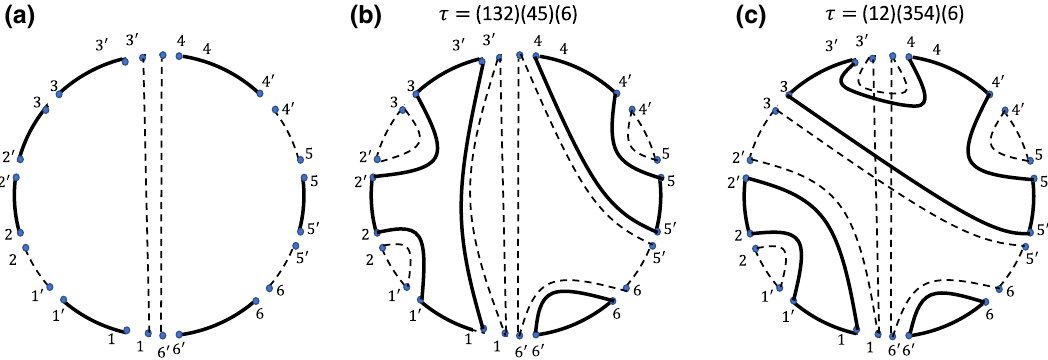
FIG. 14. Examples of the diagrammatic representation for Eq. (B9) for n = 3. (a) The contractions of indices from “future ⊗ η ⊗ e ¯ | . (b),(c) Examples of interior connections for two different choices of τ conditions” (cid:4) η A ⊗ e ¯ A A A